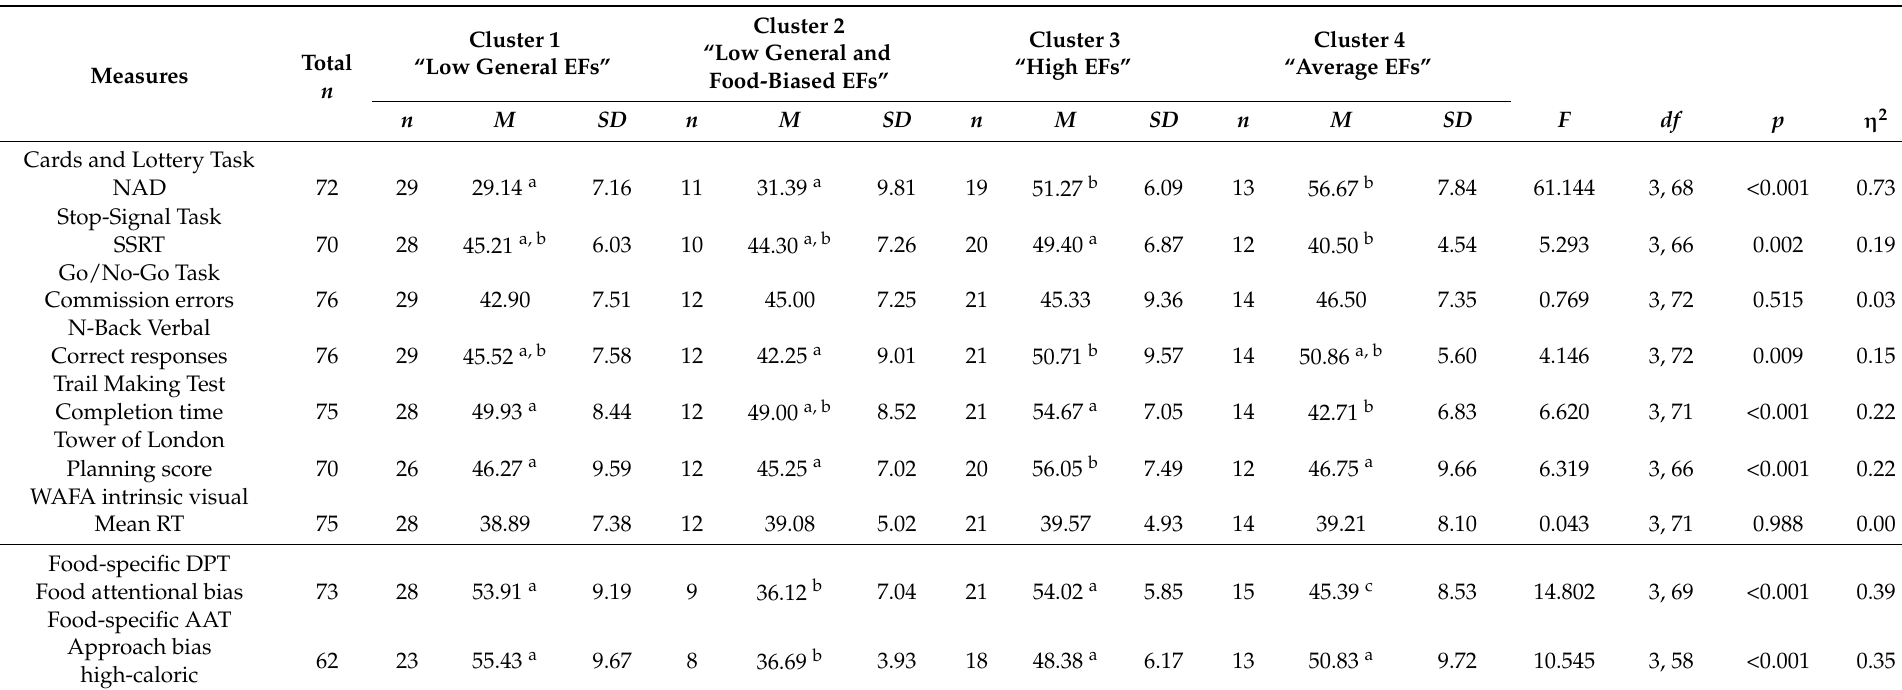
Table 3. Mean T scores, standard deviations, and one-way analyses of variance for cluster indicators covering the main components of general executive functions and food bias by cluster